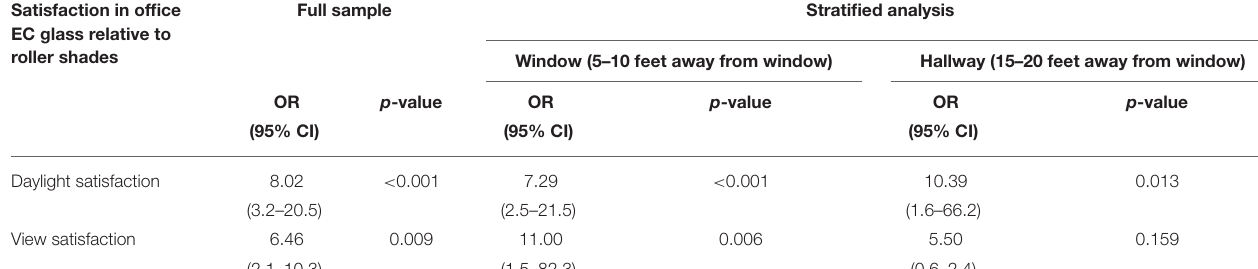
TABLE 3 | Results of the linear mixed effects models quantifying the relative odds of reporting satisfaction with daylight and views while working in the office with electrochromic glazing compared to while working in the office with roller shades (OR: odds ratio). Satisfaction in office EC glass relative to